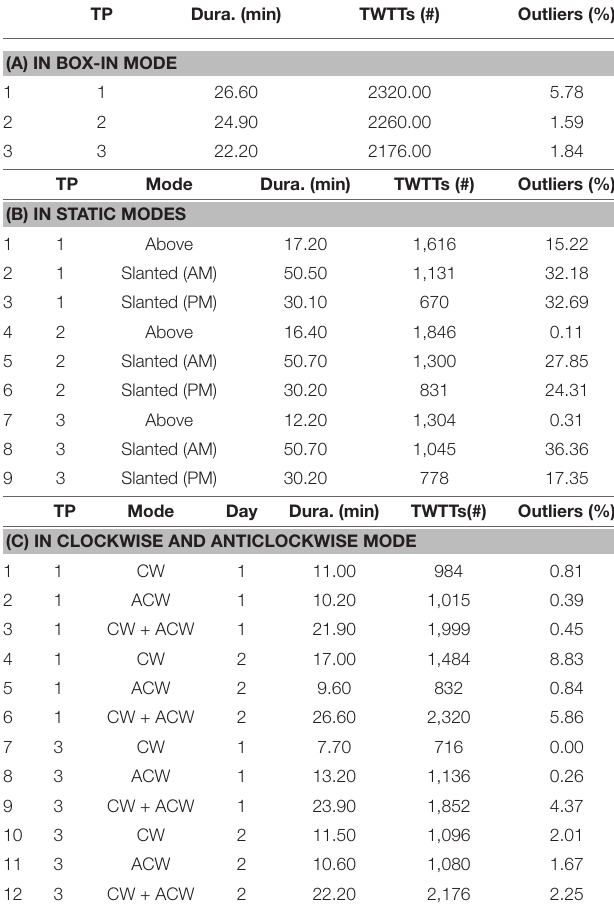
result for each of the five data subsets, and the bold/thick TABLE 2 | Acquisition duration, number of pings, and percentage of outlier pings for each transponder in the different acquisition modes. equivalent symbols represent the arithmetic mean of the five subsets, with their standard deviations. Star filled-symbols ( H ) TP Dura. (min) TWTTs (#) Outliers (%) in matching colors represent the results of the LSQ inversion for the entire period, with their formal standard deviation.